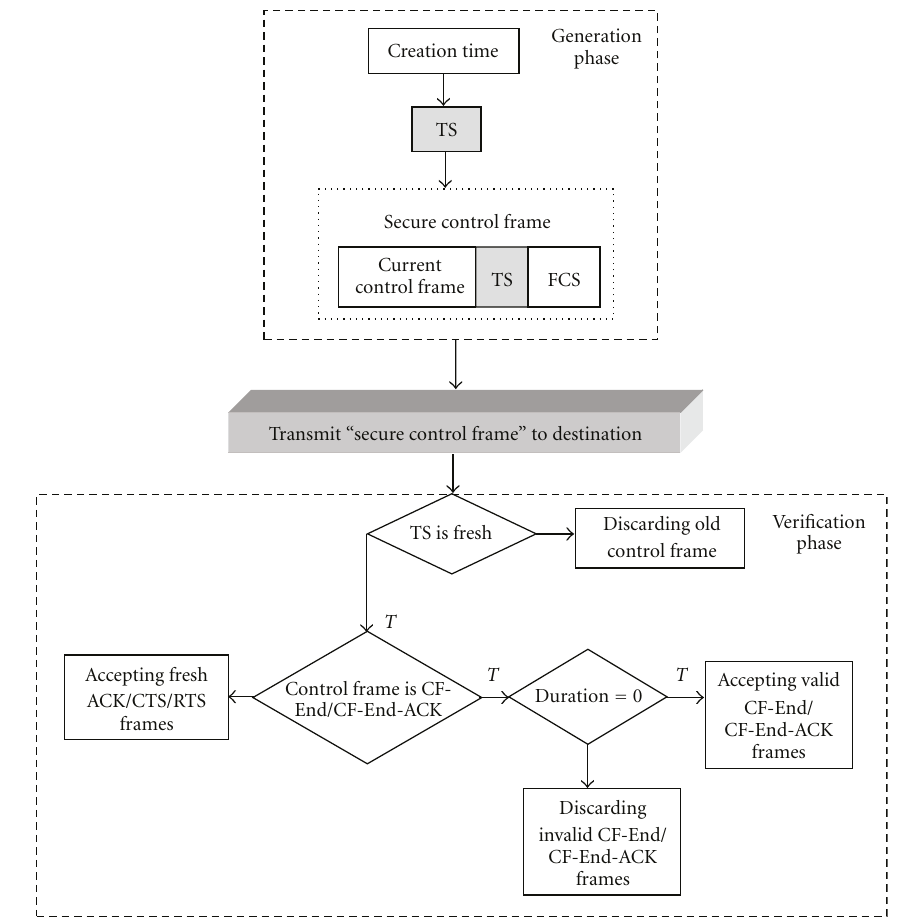
Figure 2: Algorithm of the ACFNC model.